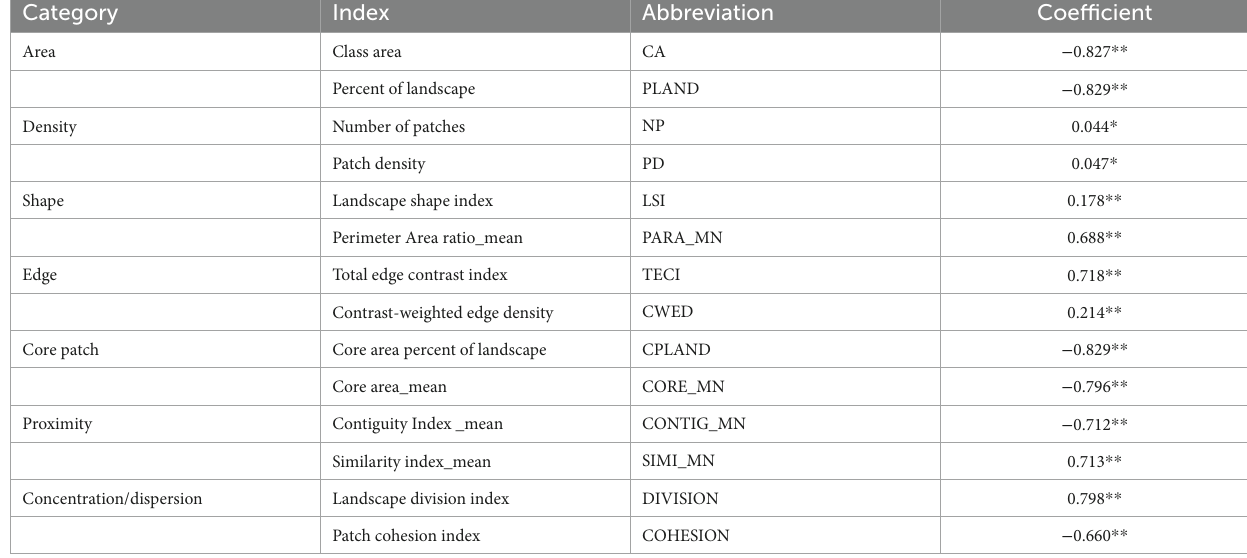
TABLE 4 Correlation coefficients between LST and the main water-related variables with the grid of 300 × 300 m (n =